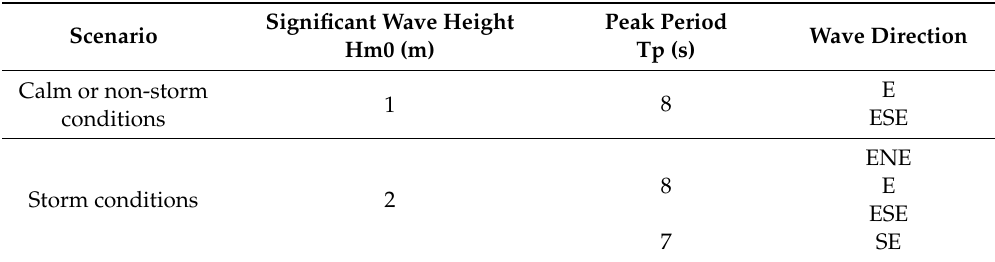
Figure 10. Joint probaility Hs, Tp, Dir: ( a ) Hs / Tp; ( b ) Hs / Dir. Table 1. Definition of the numerical simulation wave scenarios.